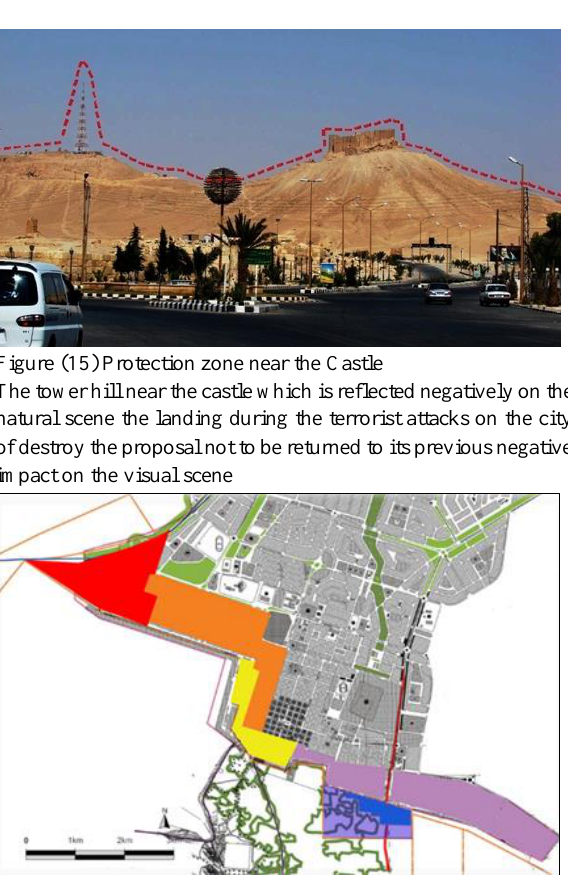
Figure(18) Initial damage assessment on the site